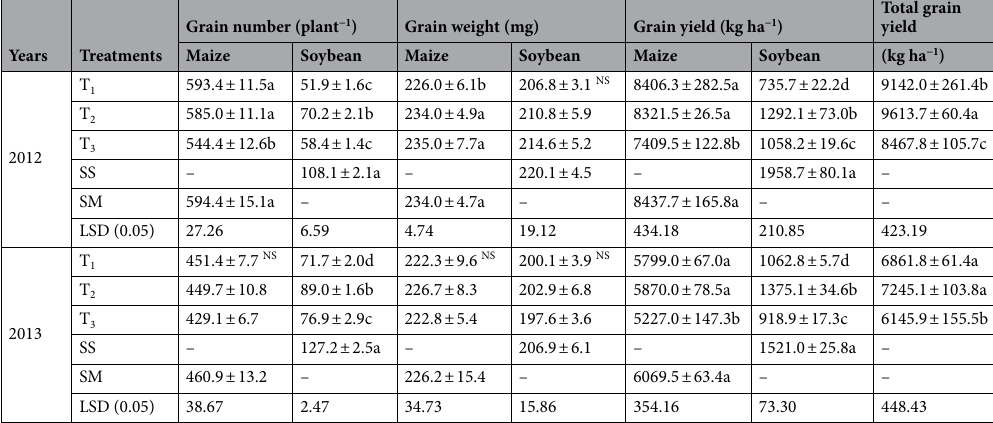
Land equivalent ratio and competition ratio. The mean land equivalent ratio values in T treatments in maize/soybean relay intercropping system were higher than the one regardless of inter-row spac- ing treatments, indicating the yield and land advantage over sole maize and sole soybean (Table 6). Among all inter-row spacing treatments in MSR, the maximum LER was 1.76 in the T 2 , whereas the minimum LER was 1.44 in the T 3 , across two years. Among the three MSR treatments, the LER was highest at the inter-row spacing of 60 cm (T 2 ) (Table 6). Similarly, the competition ratio values of intercrop species followed the same trend with LER values of T 1 , T 2 , and T 3 treatments in MSR (Table 6). Averaged across the years, the competition ratio values of maize (2.01 in T 1 , 1.29 in T 2 , and 1.53 in T 3 ) were found higher than the competition ratio values of soybean (0.55 in T 1 , 0.81 in T 2 , and 0.66 in T 3 ). However, with the medium inter-row spacing (i. e., T 2 ), the competition ratio value of soybean plants significantly increased; for example, the competition ratio values of soybean were improved by 45% and 22% in T 2 treatment compared to T 1 and T 3 , respectively, suggesting the complementarity effect between maize and soybean in medium-strips. Economic analysis. Economic analysis for soybean and maize production under maize/soybean relay intercropping systems and sole cropping systems is shown in Table 7. The highest total income (1593 US $ ha −1 in 2012 and 873 US $ ha −1 in 2013) was obtained in treatment T 2 under MSR, while the lowest total income (521